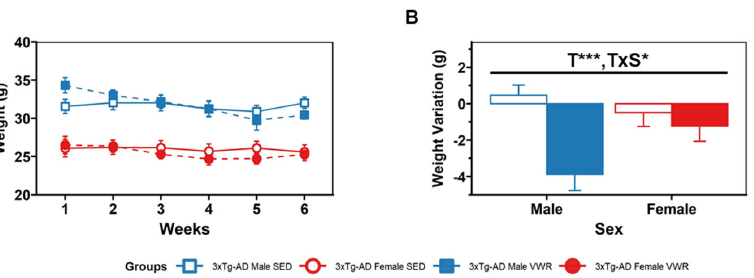
Figure 1. Body weight ( A ) at baseline (week 1) and after 30 days follow ‐ up (week 6). The interven ‐ tion took place between weeks 2 and 5. ( B ) Weight variation per group (weight at week 6 ‐ week 1). Factorial analysis: D, days; T, treatment; S, sex. * p < 0.05; *** p < 0.001.